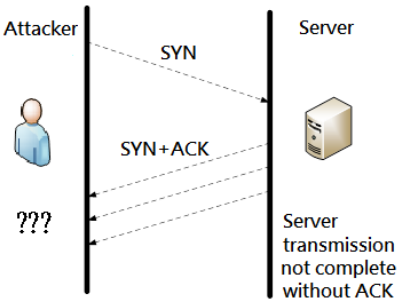
Figure 6. SYN flood attack diagram.